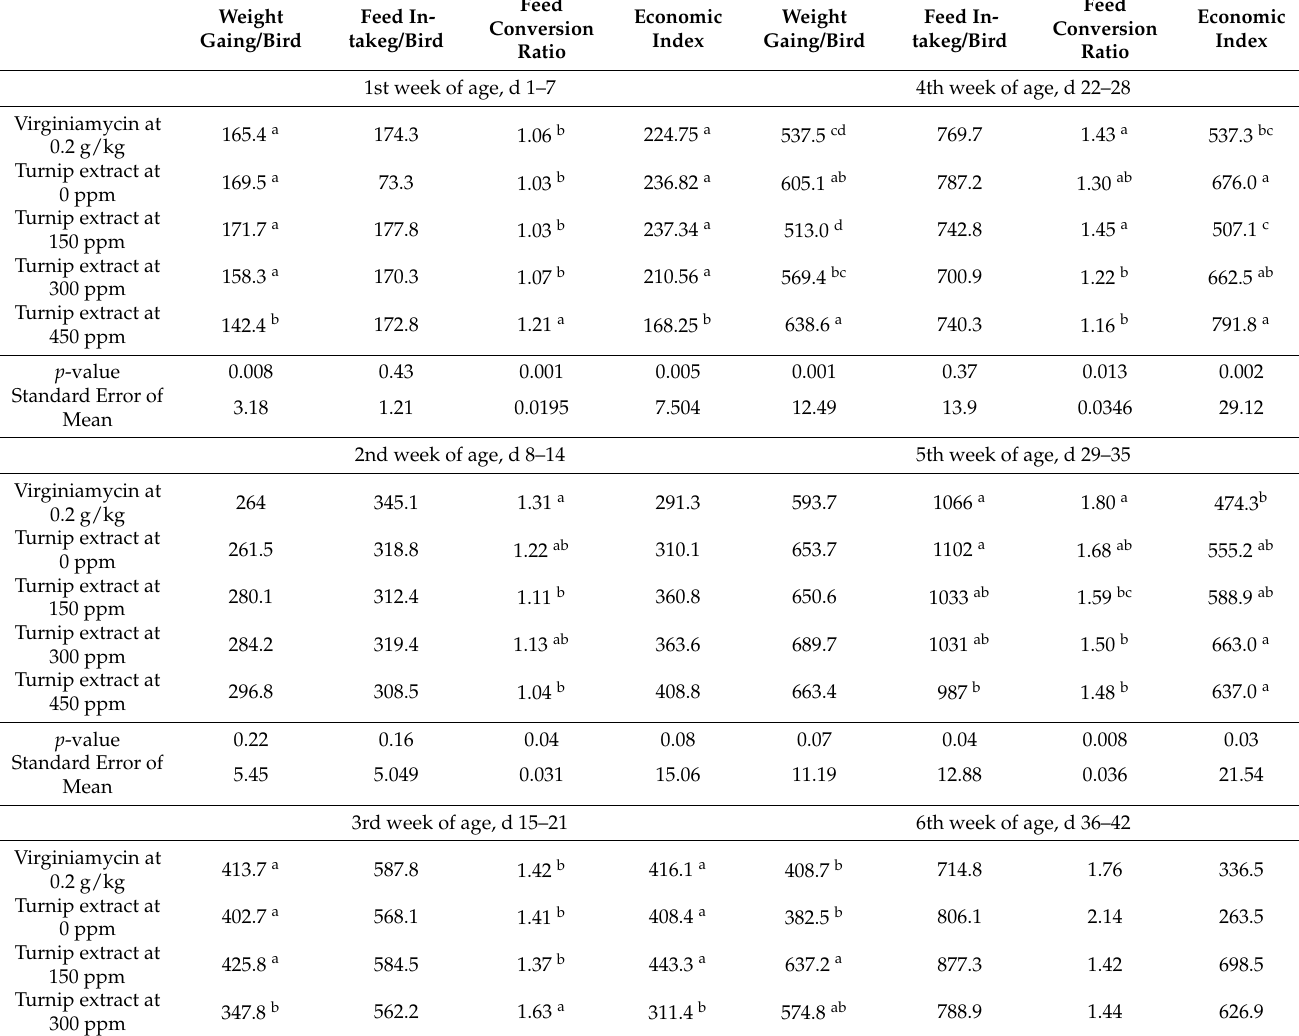
Table A1. Weekly performance mean at ± SEM of Ross 308 broilers fed the different levels of Brassica rapa extract from weeks 1–6 of age